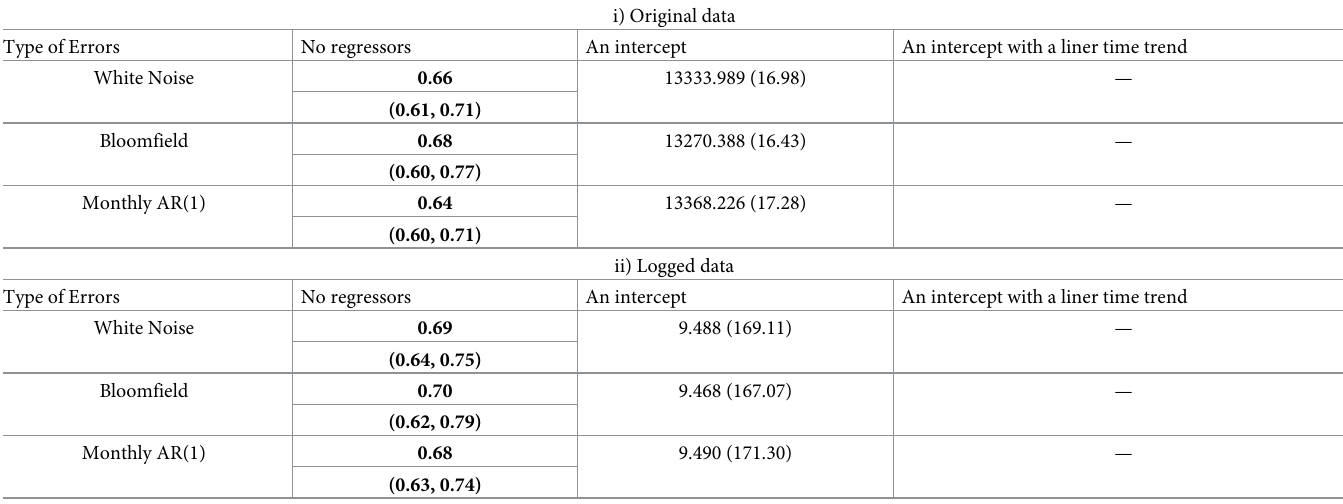
Table 2. Estimated coefficients for the selected models in Table 1: 1976m1 – 2021m4.